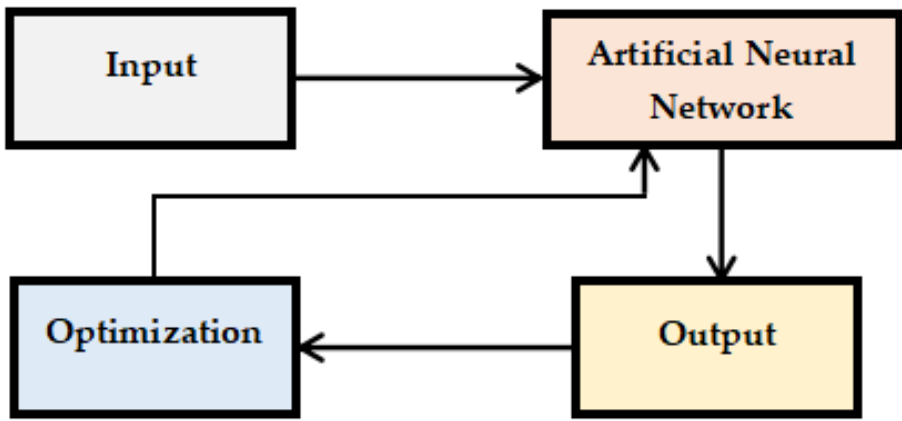
Figure 7. Neural network-based optimization approach in SGs [62].